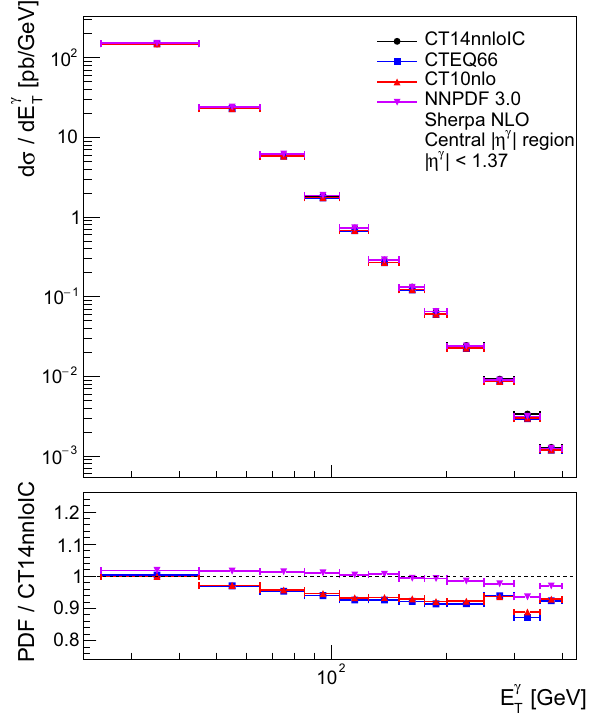
γ Fig. 5 Top: the E spectrum of photon in the central rapidity T region and with zero IC contribution using different PDFs, namely, CT14nnloIC (black points), CTEQ66 (blue points), CT10 (red points), NNPDF (lilac points). Bottom: the ratio of different PDFs to the CT14nnloIC central